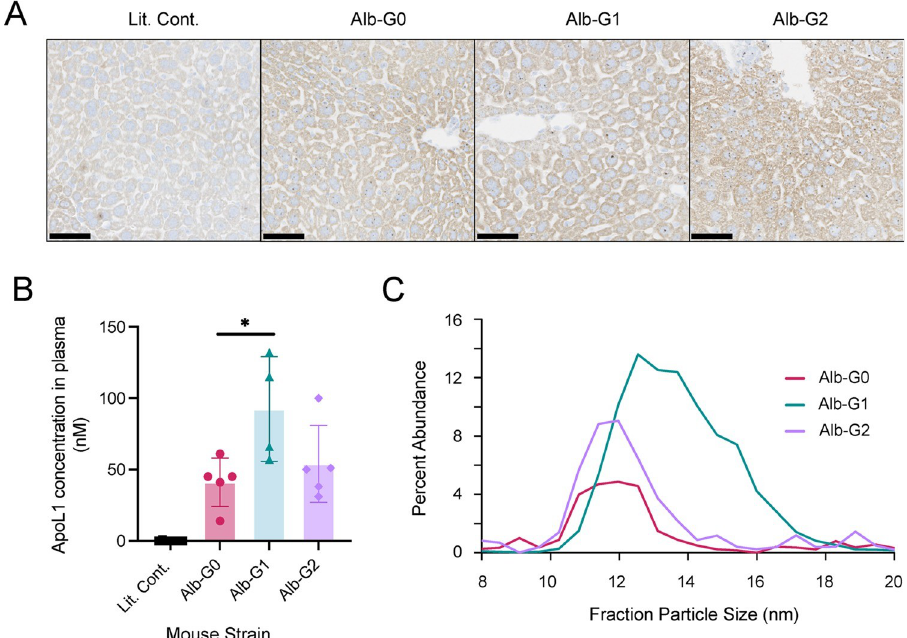
Fig 2. A novel transgenic mouse model. (A) In situ hybridization was used to detect APOL1 expression in the livers of mice expressing different alleles of APOL1 from a murine albumin promoter (Alb-G0, Alb-G1, and Alb-G2). Brown punctate staining represents detection of APOL1 RNA within hepatocytes. Scale bars are 50 μ m. (B) APOL1 expressed in the liver circulates in plasma. Circulating human APOL1 was quantified in mouse plasma after the triple intervention by using a targeted LC-MS/MS assay. Data are displayed as mean ± SD. Statistical significance was determined using Student’s t-test. � P < 0.05. (C) Compared with APOL1-G0, risk variant APOL1 resides on larger lipoprotein particles in mice. Asymmetric-flow field-flow fractionation of Alb/APOL1 mouse plasma demonstrated that APOL1-G1 is shifted to larger particles compared to APOL1-G0, similar to what is observed in human plasma. The effect was less substantial in Alb/APOL1-G2